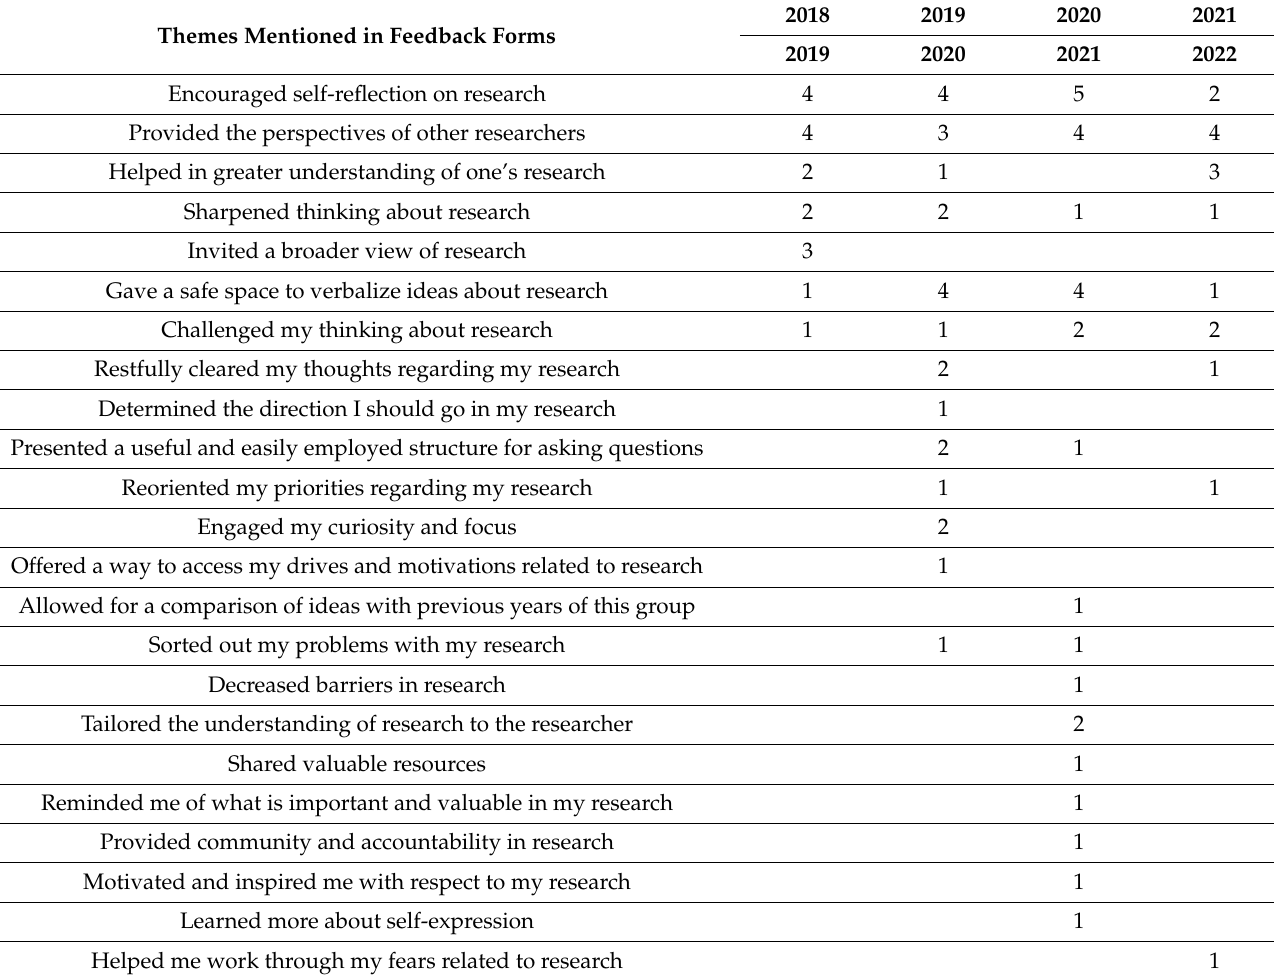
Table 3. Themes Mentioned in Responses Provided on the April Feedback Forms to “How Was the Group Valuable to You as a Researcher?” For Each of the Four Most Recent Academic Years in Order of Receipt of Feedback Forms from HeNReG